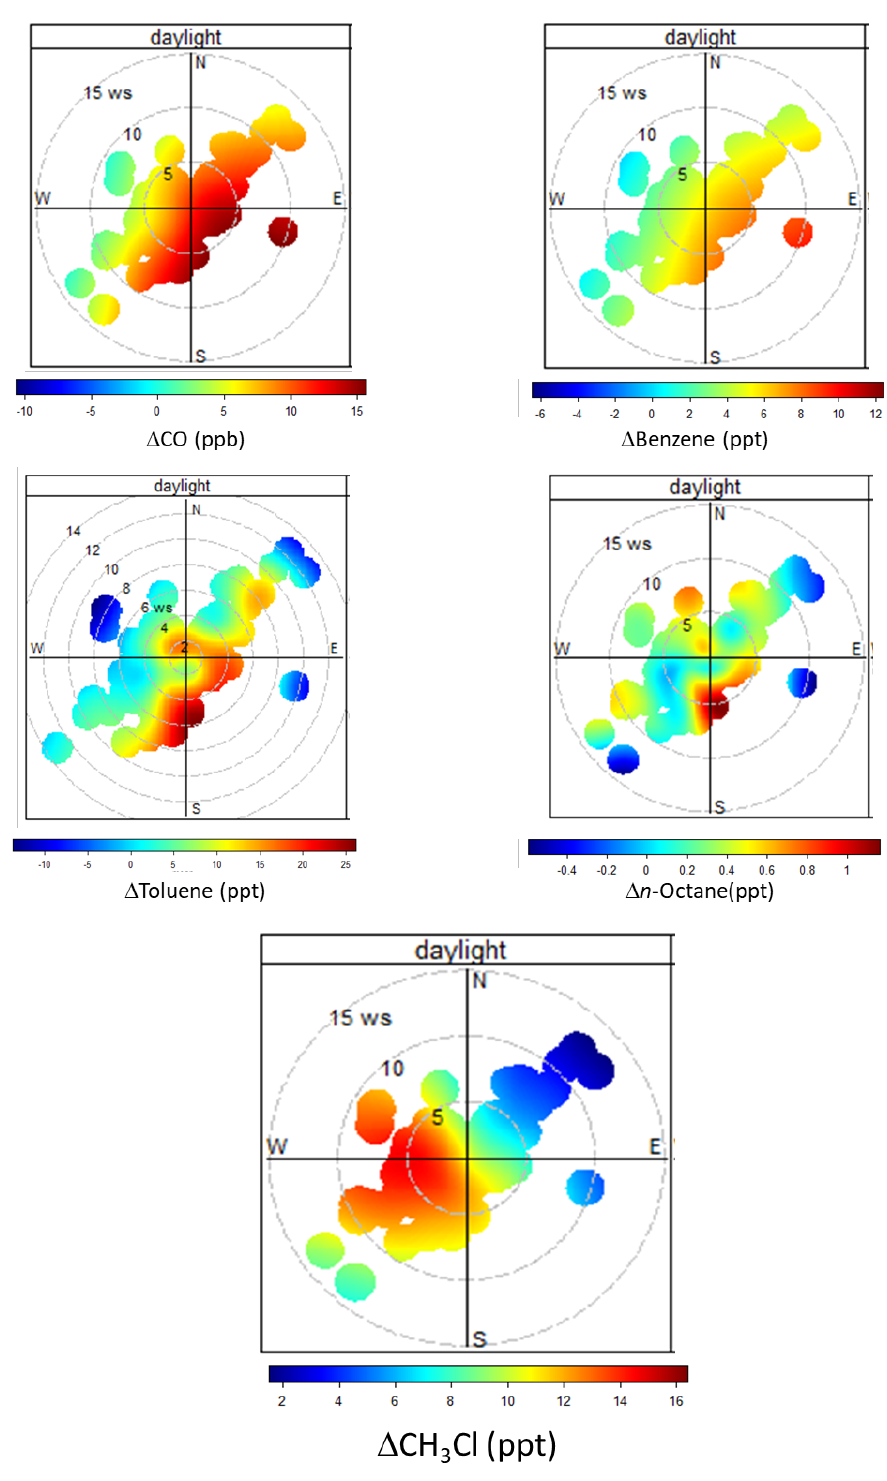
Figure 11. Bivariate analysis of the mean average residuals of CH 3 Cl, CO, benzene, toluene, and n-octane for CH 3 Cl enhancement events (i.e., positive residuals) during summer 2017 (daytime). Please note that for CH 3 Cl only positive enhancements are shown.